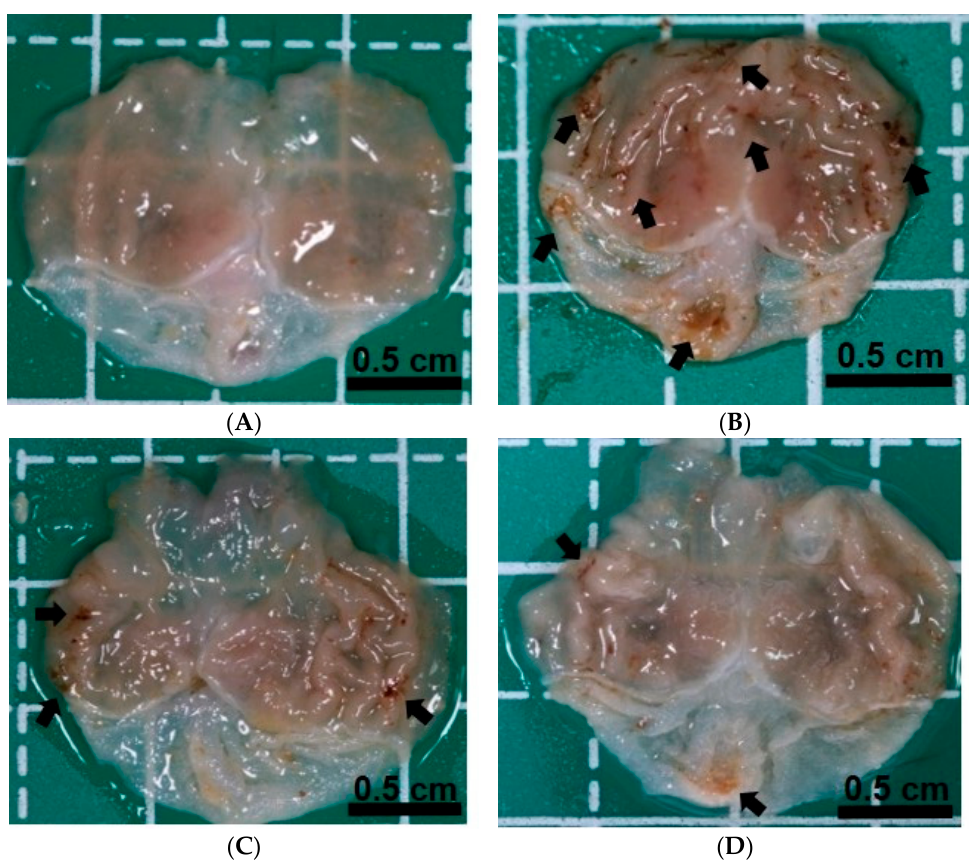
Figure 1. Representative gross gastric images of mice. ( A ) Control group; ( B ) IND group, treated with IND (120 mg/kg); ( C ) EEDH200 group, treated with EEDH (200 mg/kg) + IND (120 mg/kg); ( D ) EEDH500 group, treated with EEDH (500 mg/kg) + IND (120 mg/kg). Mice were administered indicated dose of EEDH orally for 21 consecutive days. 120 mg/kg of IND was then given orally to mice on the last day of experiment and sacrificed 6 h later. The gastric tissue of mice was harvested and photographed. The arrows showed in the figure depict bleeding ulcers. Table 1. Effects of EEDH on gastric ulcer area and protective index in mice treated with IND.